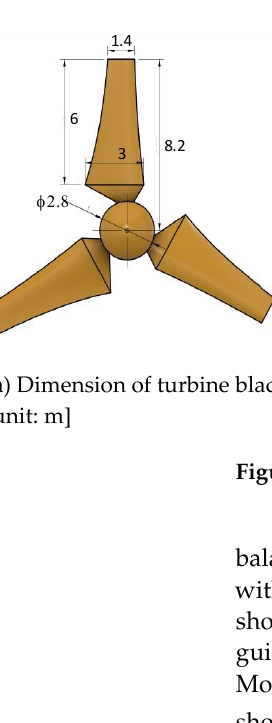
Figure 6. Dimension of the convertor.